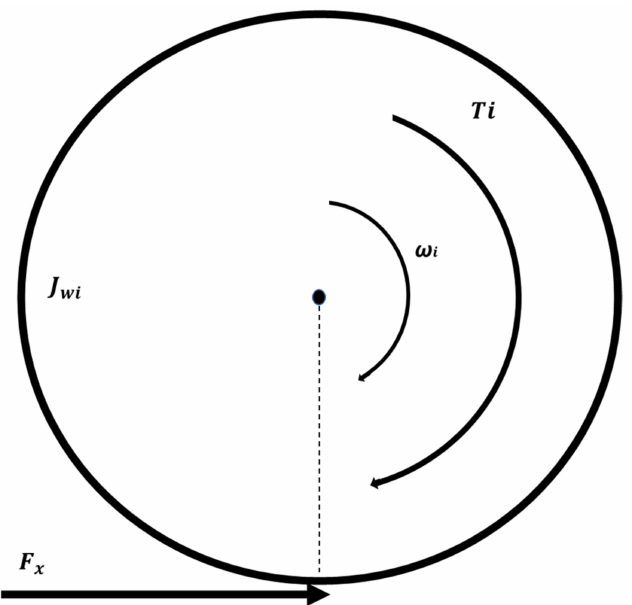
Figure 2. Free body diagram of one